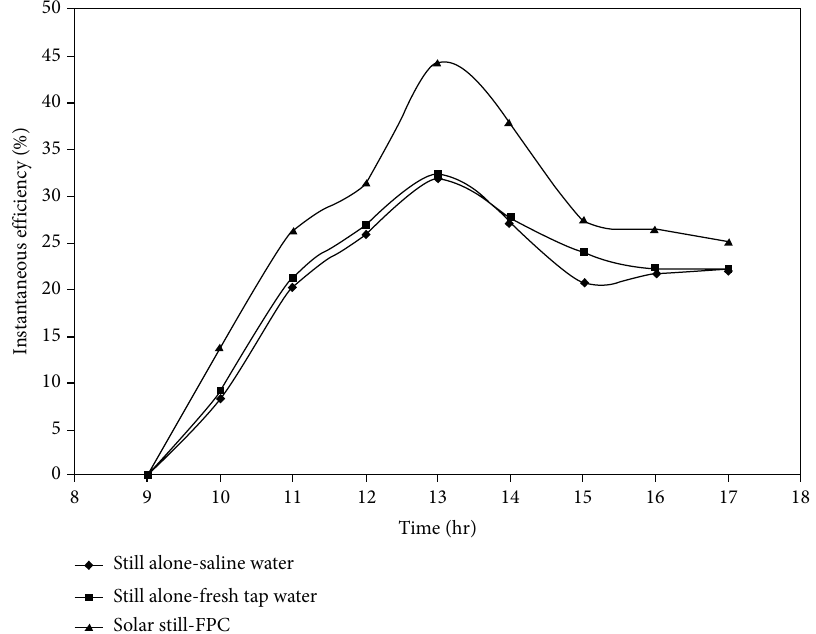
Figure 10: Comparing e ffi ciency of the solar stills with freshwater, saline water, and the solar still coupled with a fl at plate collector with freshwater